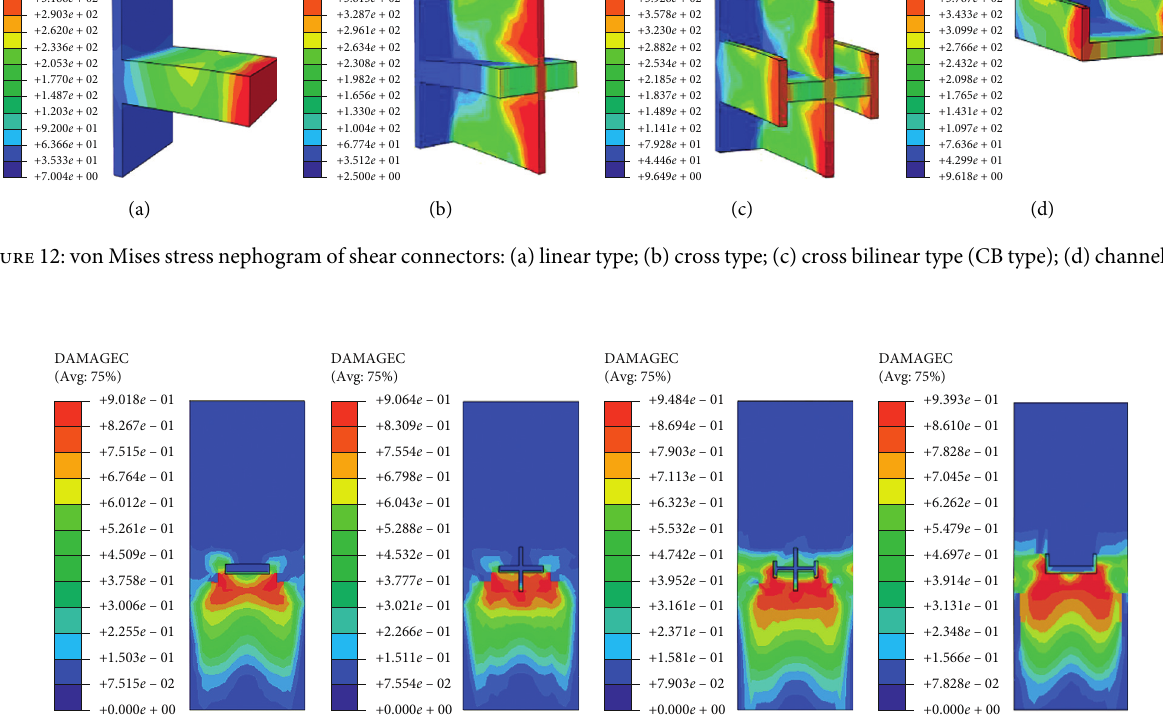
1 ; (b) B 2 ; (c) B 3 ; (d) B 4